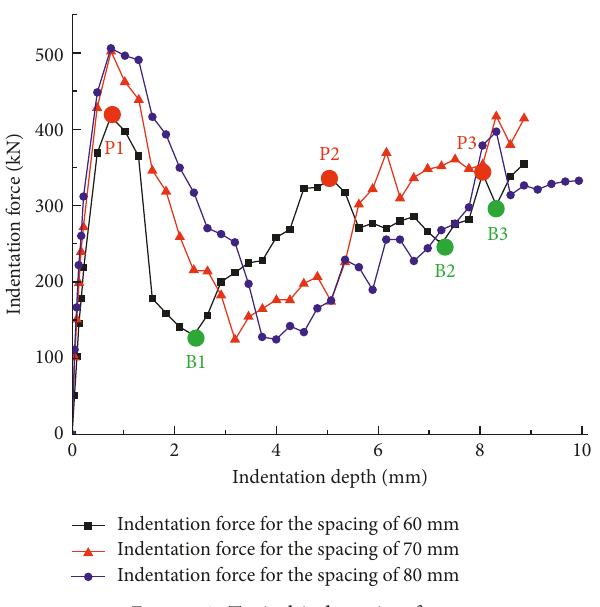
Figure 10: Numerical indentation energy. Figure 9: Typical indentation